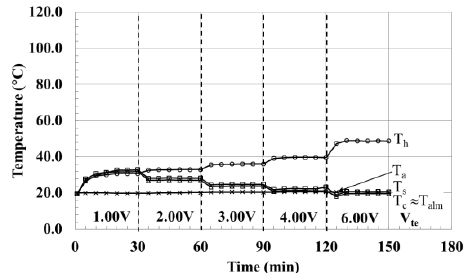
Figure 8. Transient temperatures for the FHS-TE assembly (FC (forced convection), P EH = 10 W, Run